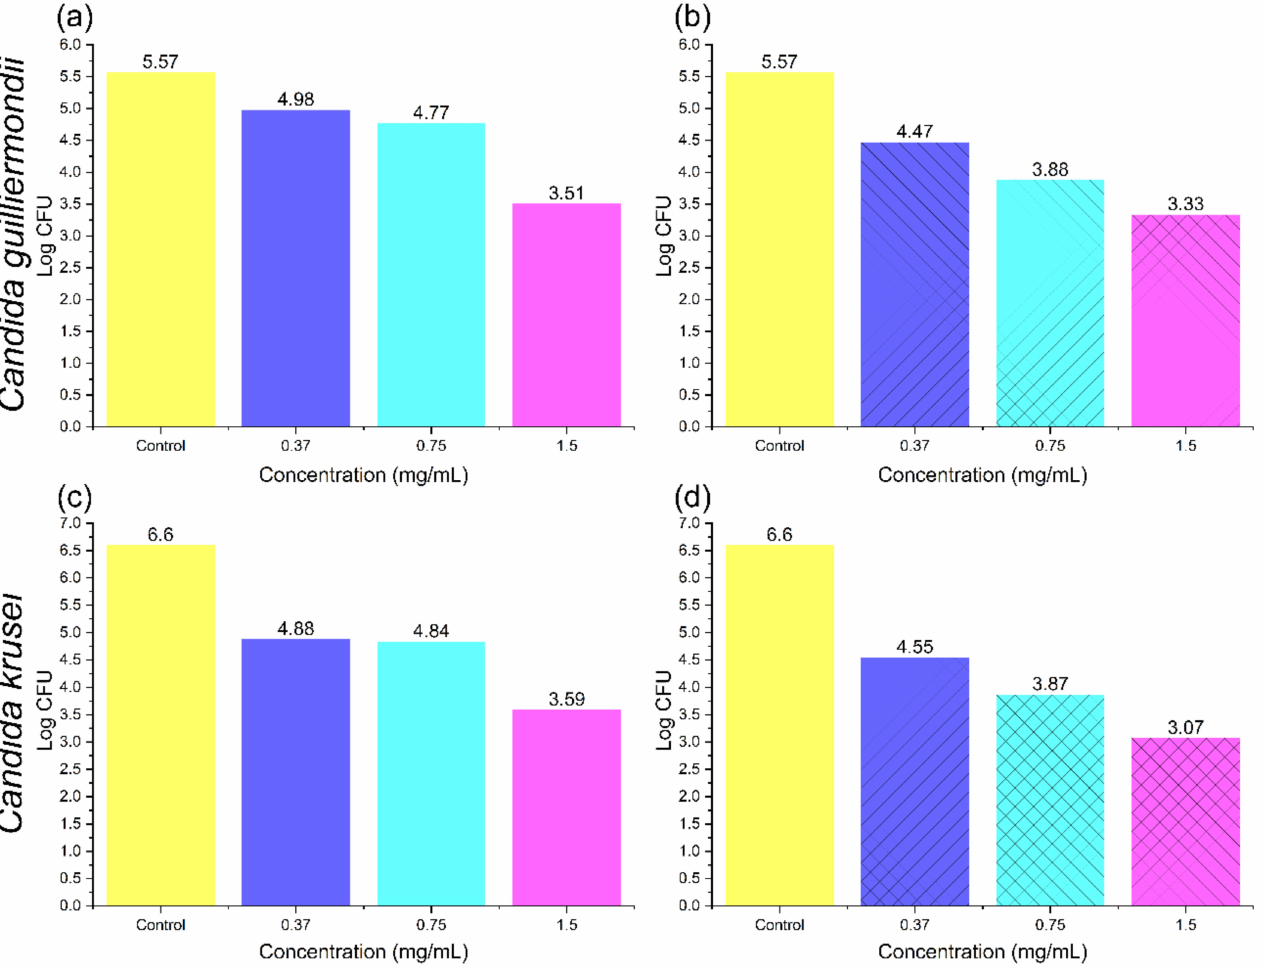
Figure 8. Antifungal activity on Candida guilliermondii and Candida krusei of ( a , c ) coffee husk, and ( b , d ) AgNPs–coffee